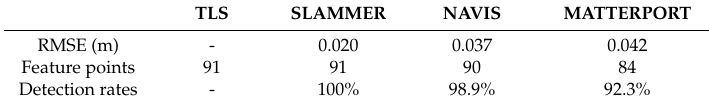
Table 7. Accuracy assessment results for the interactive selected feature points of the